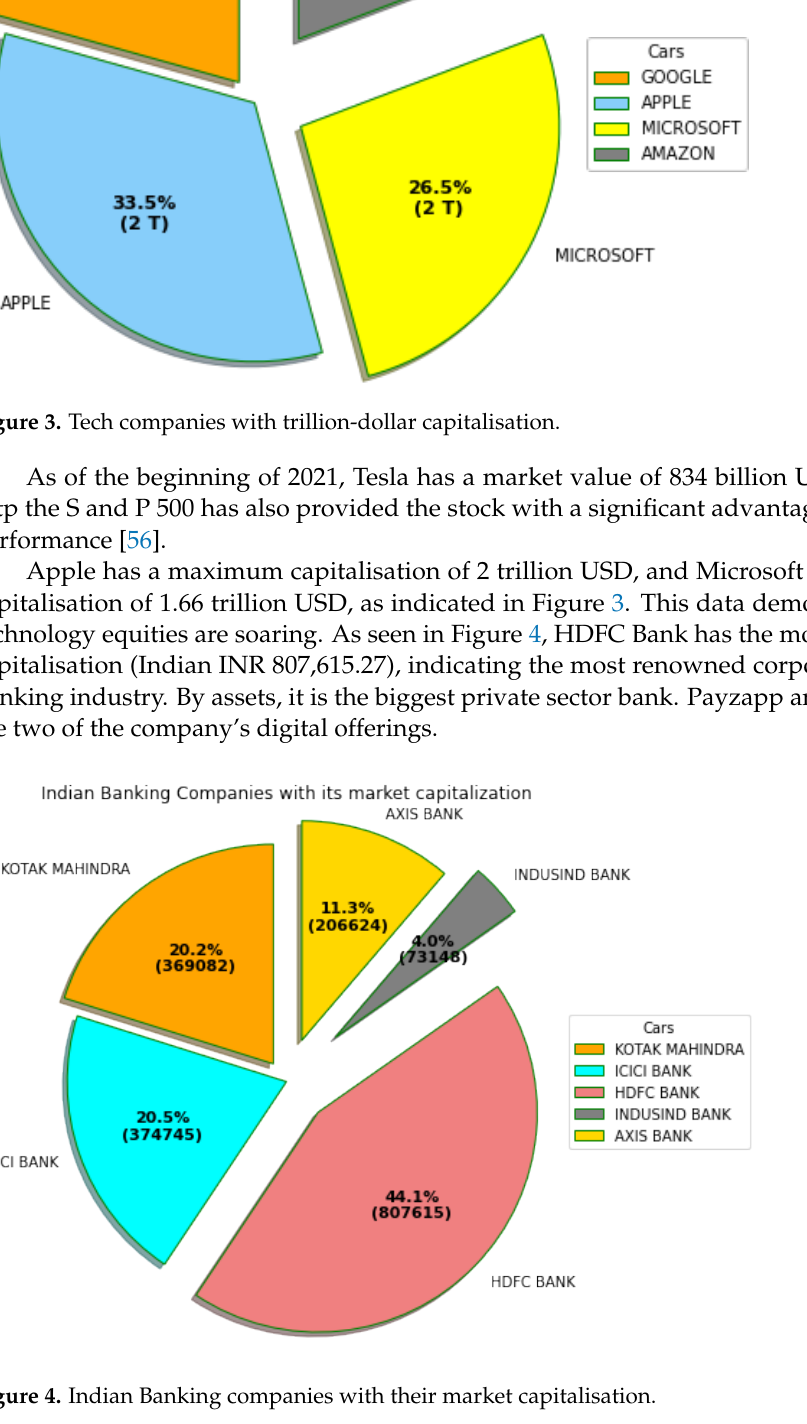
Figure 4. Indian Banking companies with their market